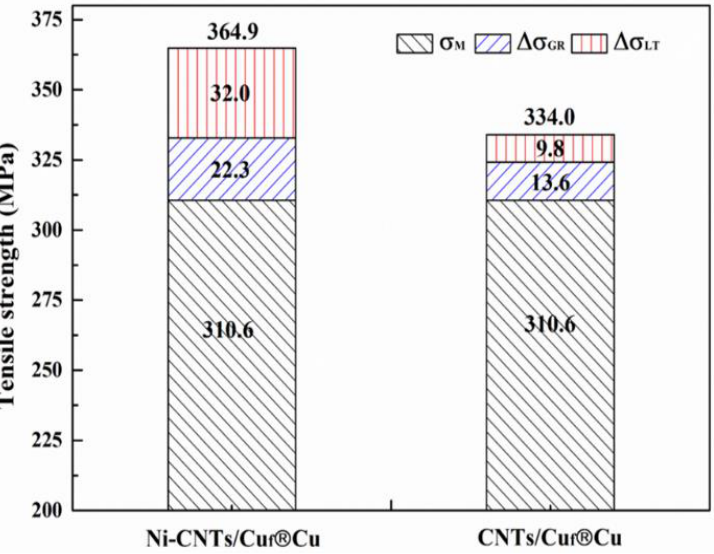
Figure 10. Strengthening factors in composites.